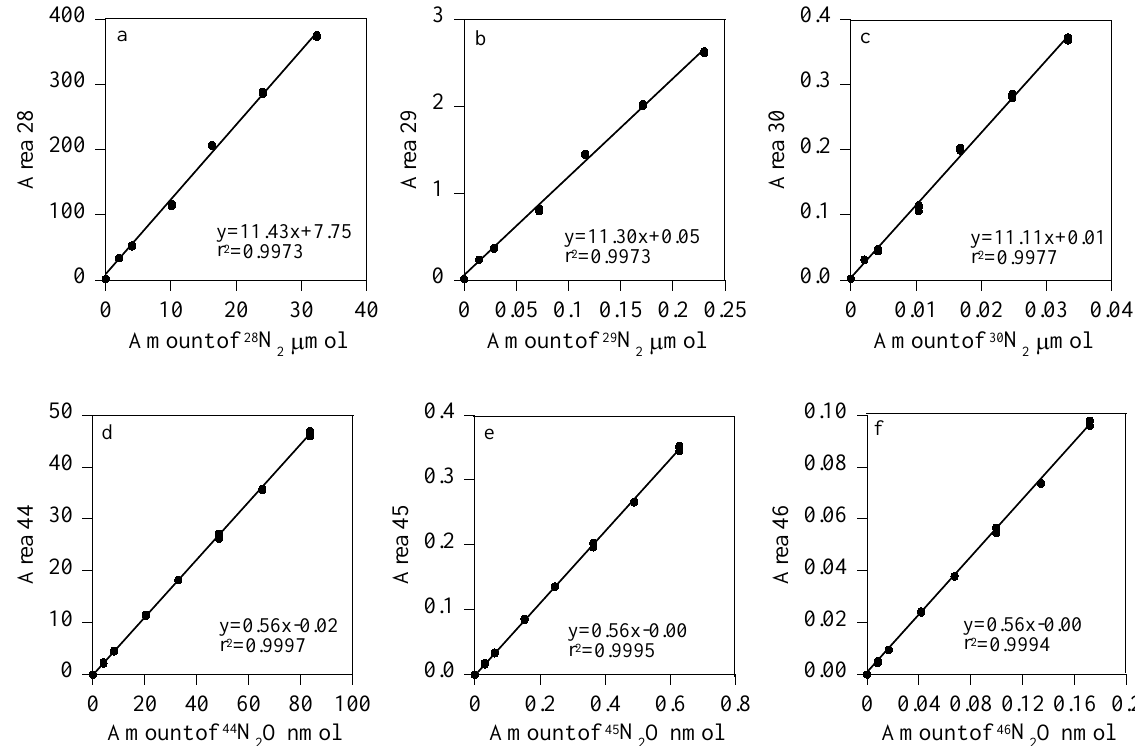
Fig. 3. (a, b, c) Linear responses of signal area m/z 28, 29 and 30 against given amounts of standard gas 28 N 2 , 29 N 2 and 30 N 2 , respectively. (d, e, f) Linear responses of signal area m/z 44, 45 and 46 to various amounts of stand gas 44 N 2 O, 45 N 2 O and 46 N 2 O, respectively. Figure 3. (a, b, c) Linear responses of signal area m/z 28, 29, 30 against given 915 3 Development of amounts of standard gas 28 N signal area m/z 44, 45, 46 to various amounts of stand gas 44 N respectively. 918